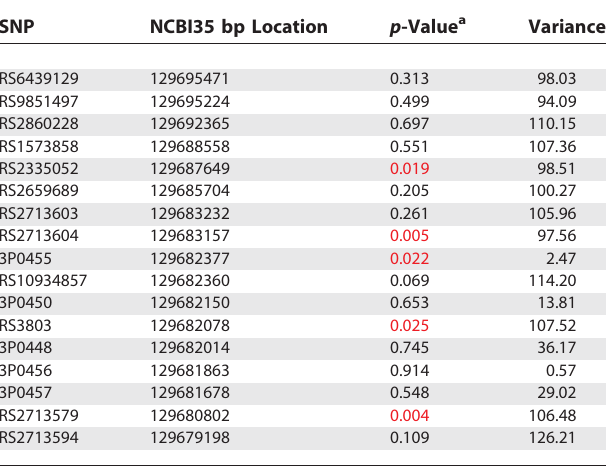
Table 4. GATA2 SNPs Are Associated with Early-Onset CAD in